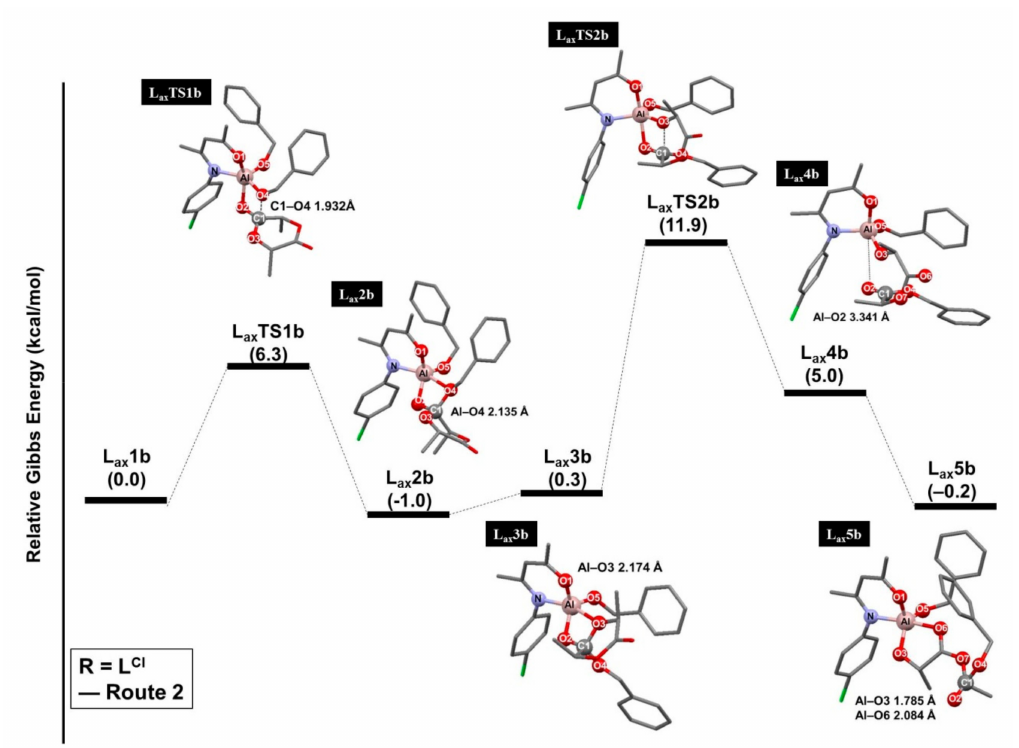
Figure 10. Reaction profile and optimized structures of the L Cl system. (Monomer: L